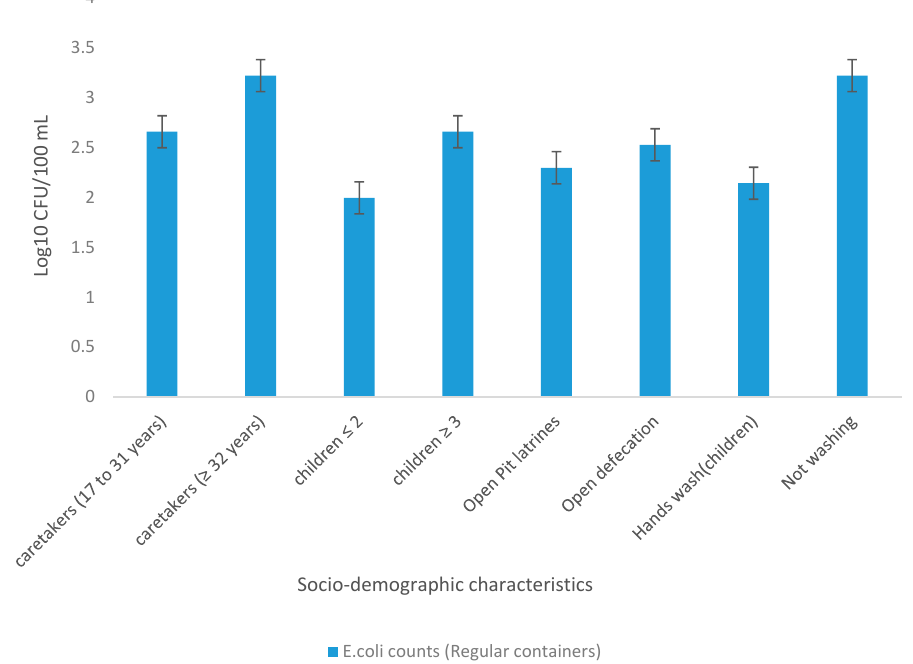
Figure 7. Mean concentration of E. coli (Log10 CFU/100 mL) in treated water collected from regular storage container versus socio-demographic characteristics.